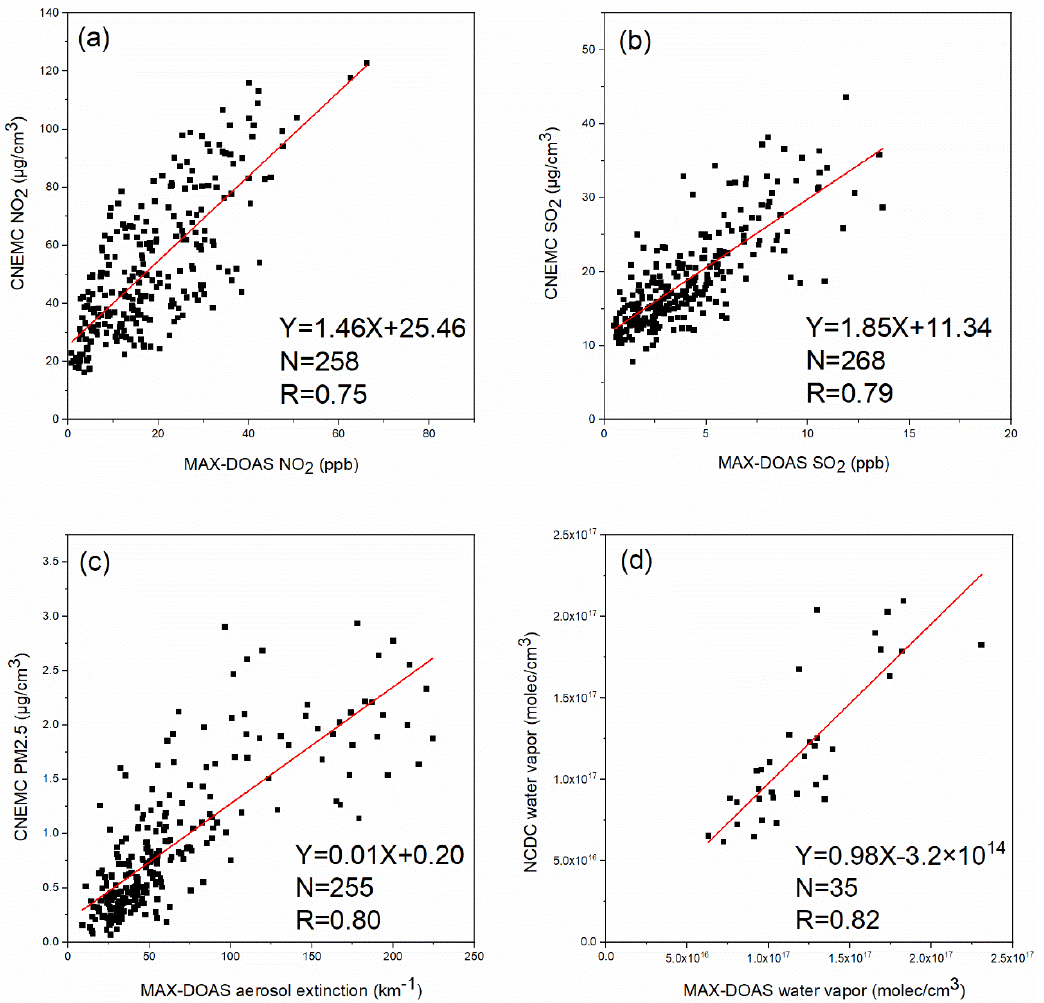
Figure 3. Correlation analysis between NO 2 , SO 2 surface concentrations, aerosol extinction, water vapor observed by MAX-DOAS and CNEMC, NCDC datasets. ( a – d ) is NO 2 , SO 2 , aerosol extinction, and water vapor respectively.